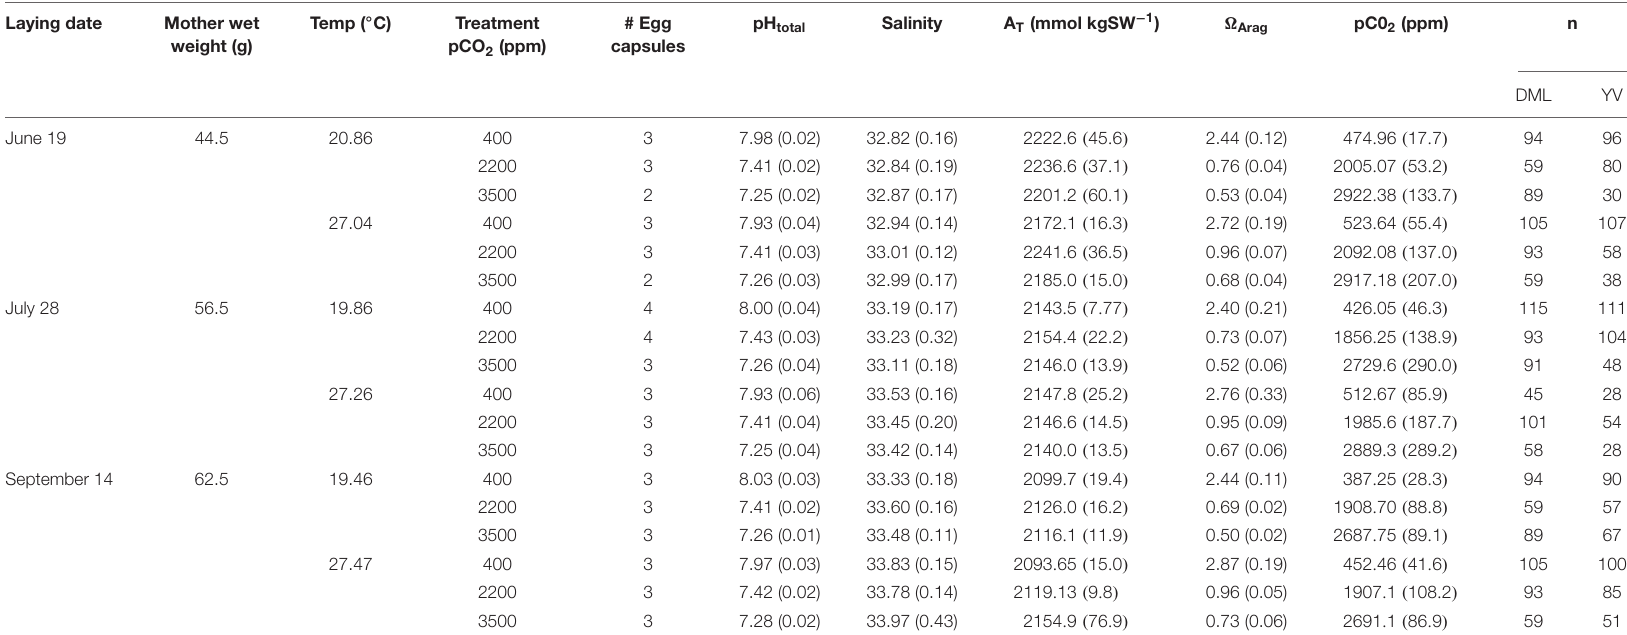
TABLE 1 | Seawater chemistry, maternal wet weight, number of egg capsules, and number of paralarvae subsampled for each treatment of each trial. Laying